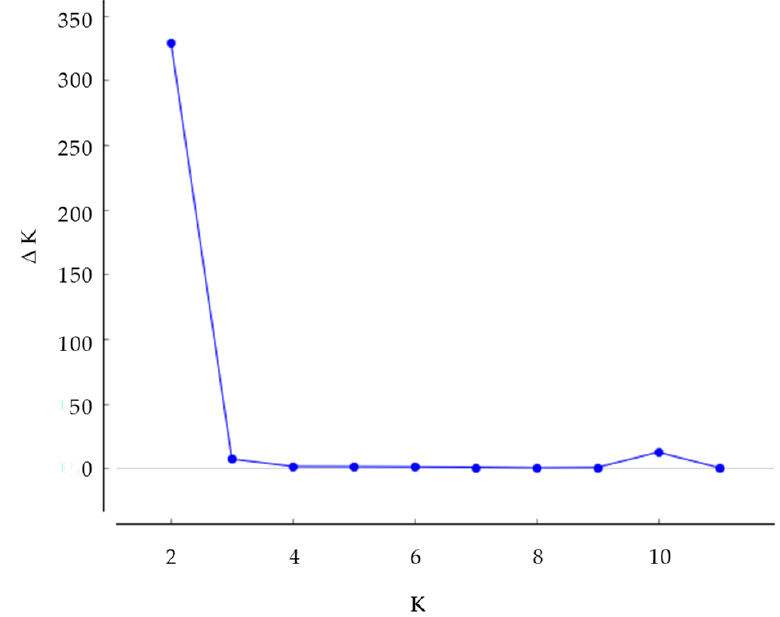
Figure 4. Delta K values for STRUCTURE analysis of Pseudotsuga menziesii (Mirb.) Franco populations, where ∆ K , calculated according to Evanno et al. [46] is plotted against the number of modeled gene pools ( K ). Table 6. Estimated proportion of ancestry (Q) [42] for the 12 Pseudotsuga menziesii (Mirb.) Franco populations analyzed.